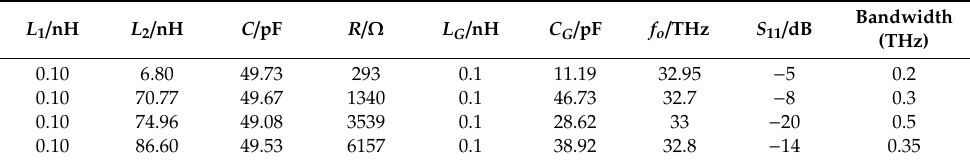
Table 1. Optimization of R, L, and C circuit parameters response on the resonance